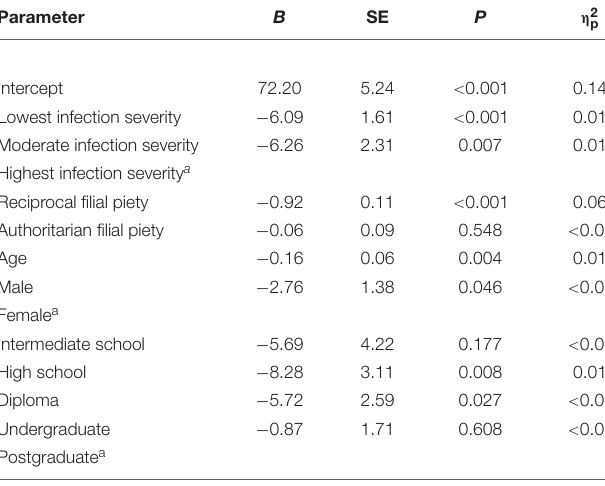
TABLE 6 | Parameter estimates for model predicting mental